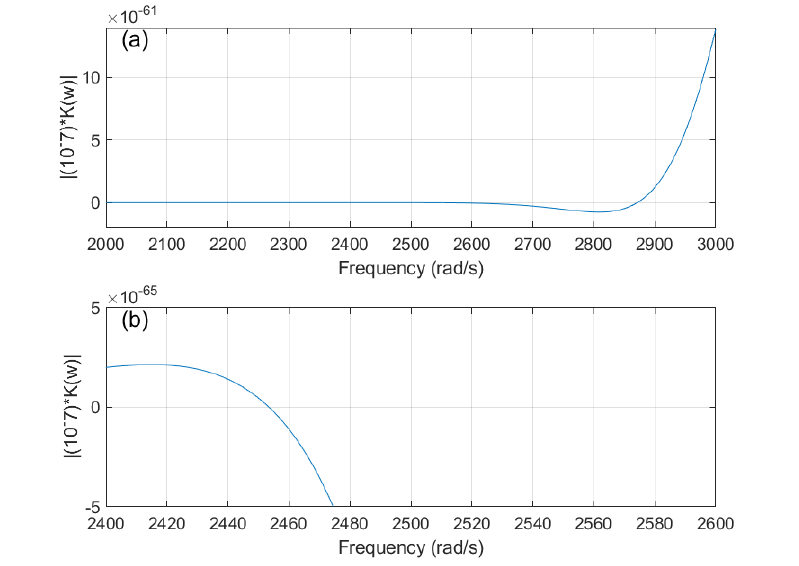
Figure 24. Mode Plot of Timoshenko beams in Topology 1 with hinged ends using DSM; original configuration ( a ) a selected region of natural frequencies showing zero–crossing at the 10th natural frequency ( b ) a detailed section showing zero–crossing at the 9th natural frequency.